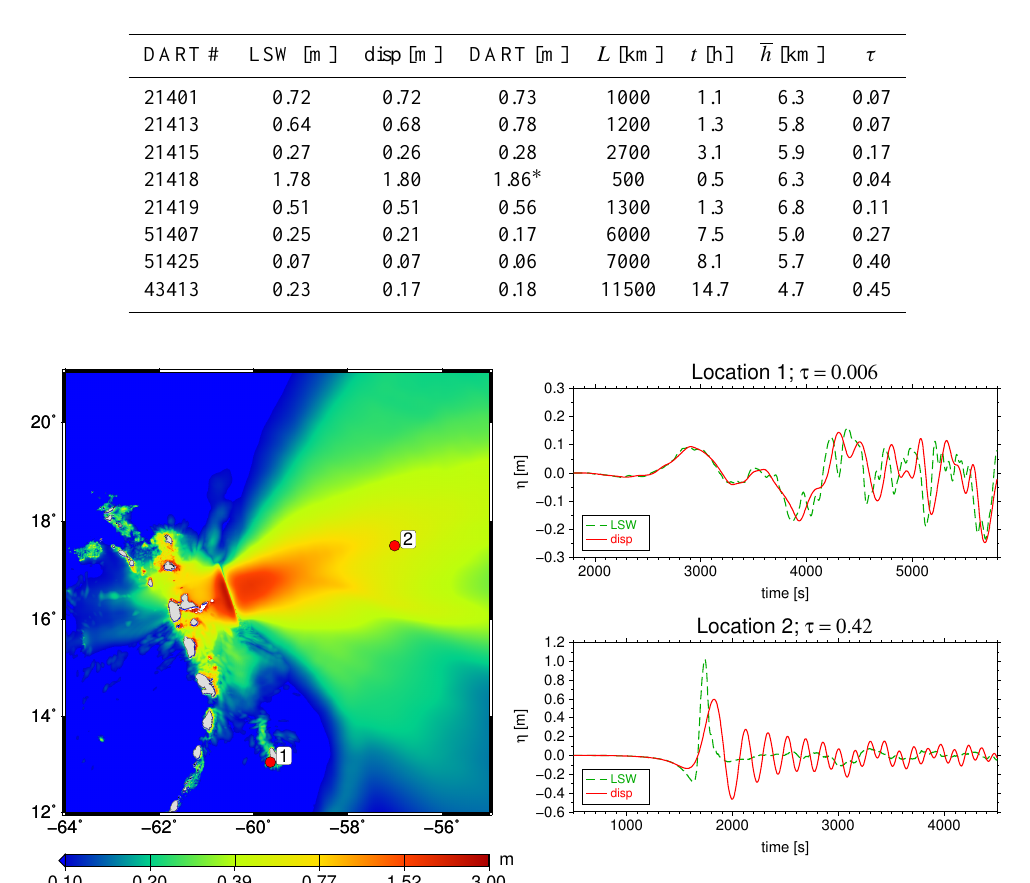
Table 1. The values of τ for eight different DART buoys, together with the simulated (linear hydrostatic - “LSW”, and linear dispersive - “disp”) and measured (“DART”) height of the leading wave. L is the propagation distance, t is the propagation time, while h is the average sea depth (calculated by using t and the LSW propagation speed, q gh ). (DART 21418 – uncertain value due to coarse resolution of the data.)